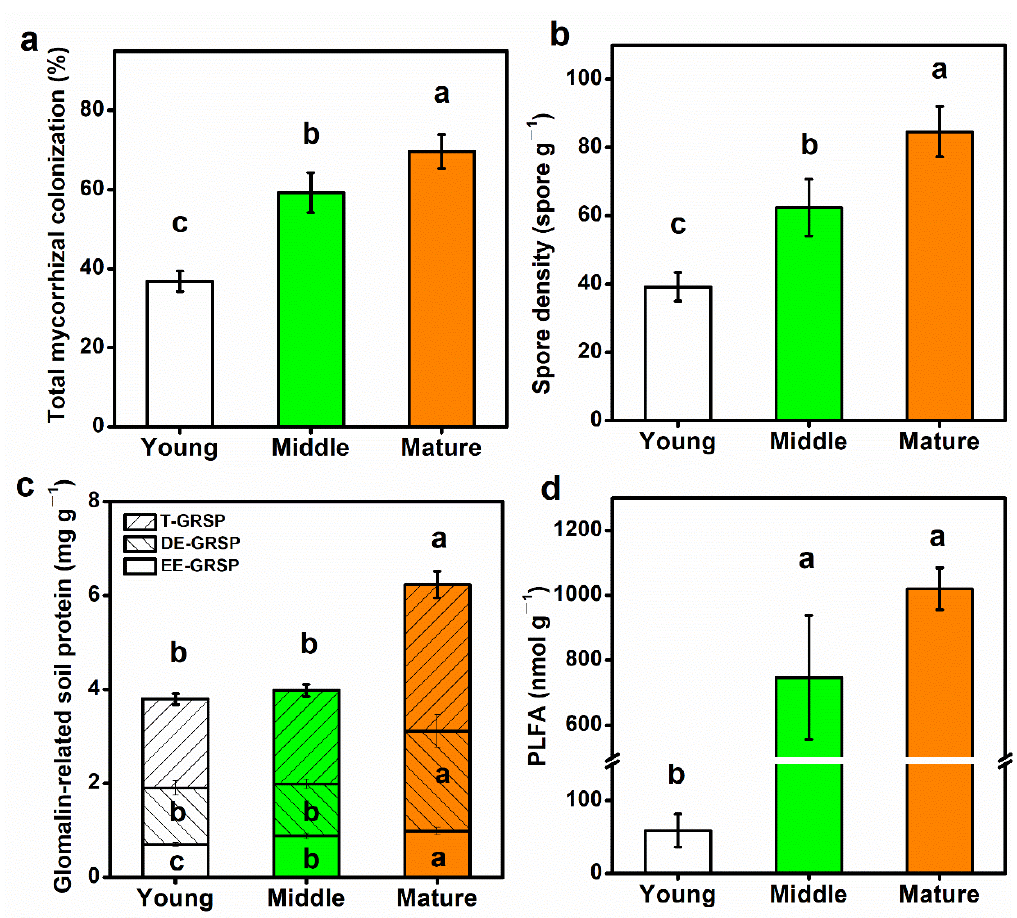
Figure 1. Total colonization rate ( a ), spore density ( b ), GRSP contents ( c ) and AM fungal biomass ( d ) in different C. lanceolata plantations. Bars topped by different letters indicate significant difference ( p <